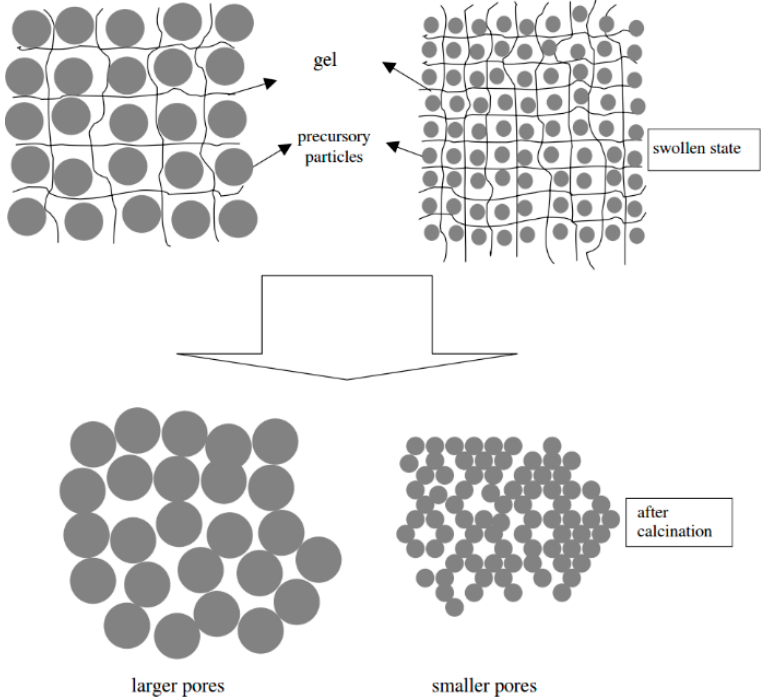
Figure 2. Potential impact of hydrogel mesh size on the porosity of the product. Reprinted with permission from [42], Copyright 2003 Elsevier.